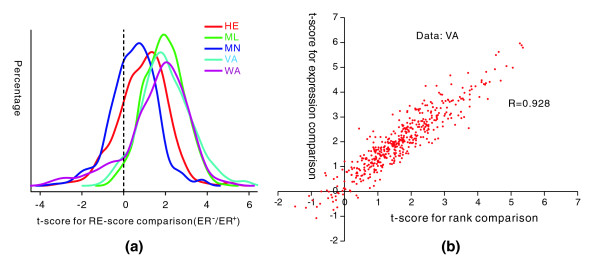
Results obtained from an alternative RE-score calculation method based on expression comparison. (a) Distributions of the t-scores calculated by comparing the RE-scores from the expression comparison method. The employed target prediction algorithm was PITA. The t-score distributions for the five datasets are shown in different colors. (b) Correlation between the t-scores obtained from the two different RE-score calculation methods. The microarray dataset used was VA, published by van't Veer et al. [34]. The correlation coefficient (R) is 0.928, indicating that the t-scores obtained using expression comparison and rank comparison are highly correlated.